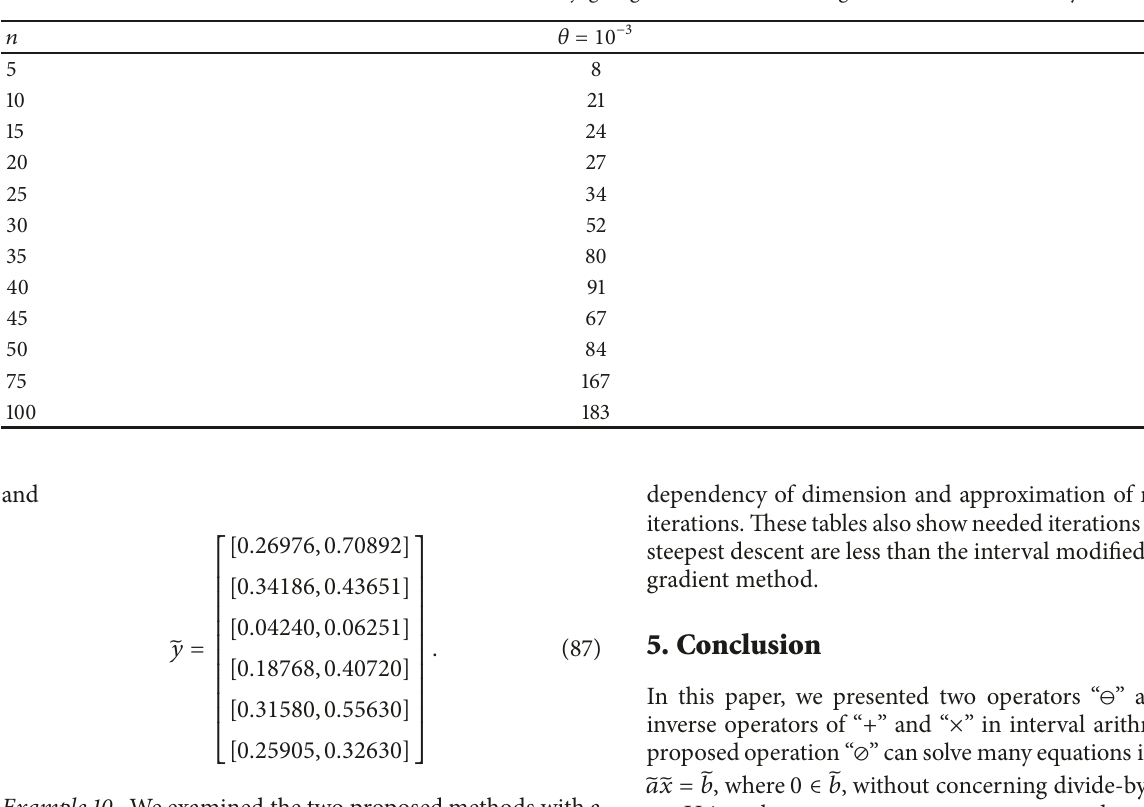
Table 5: Iterations needed in interval modified conjugate gradient method solving random linear interval